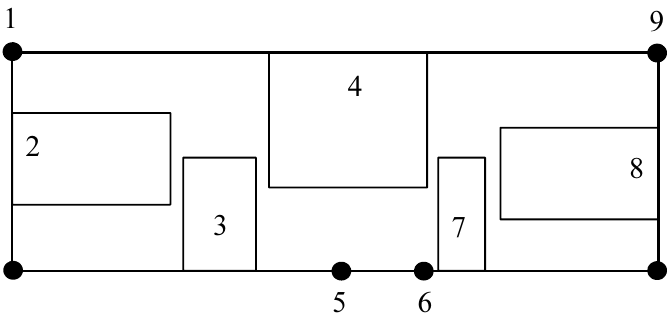
Figure 18. The compaction step of the plane sweep